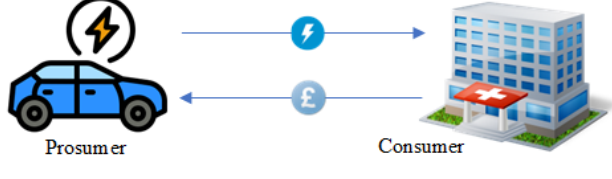
Figure 2. Types of energy trading in V2G